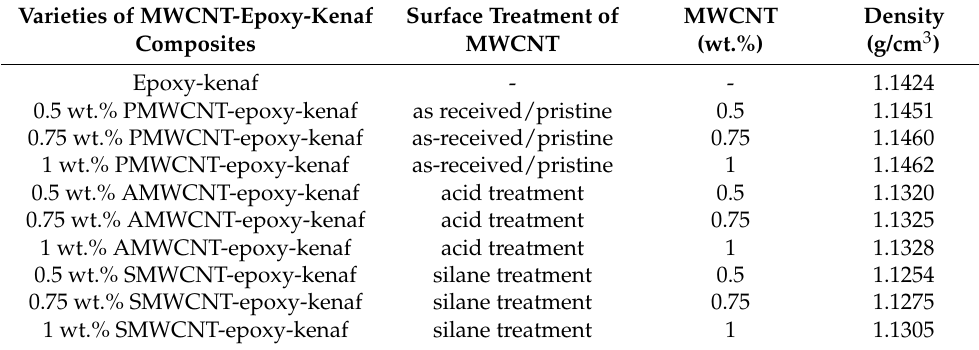
Table 1. The formulation of multiwall carbon nanotube (MWCNT)-epoxy-kenaf composites.